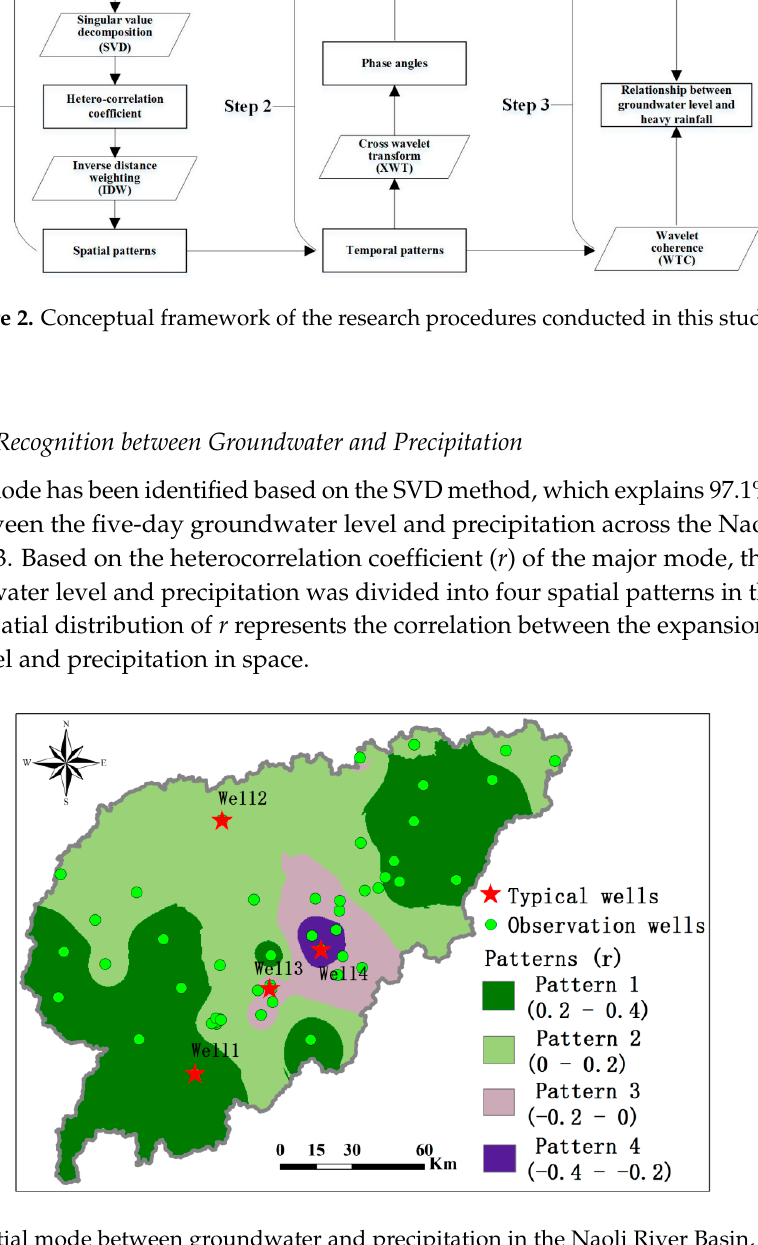
Figure 3. Spatial mode between groundwater and precipitation in the Naoli River Basin, Northeast China, based on the SVD method. China, based on the SVD